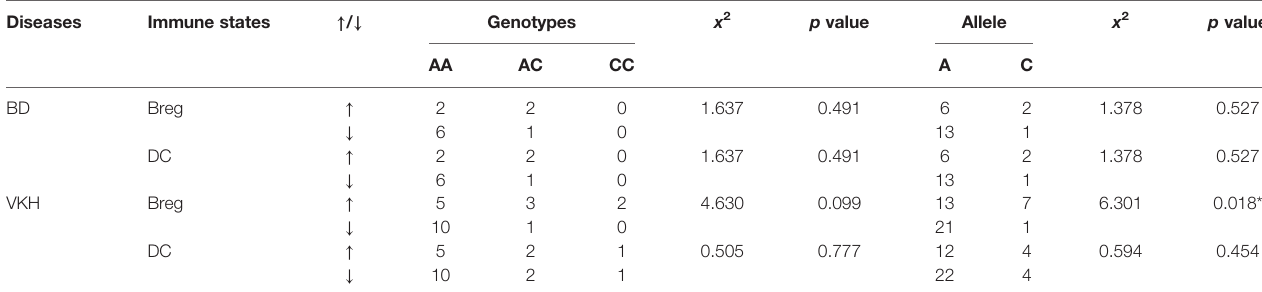
TABLE 5 | Associations of IL-12p35 (rs2243131) with immune states in BD or VKH patients. Diseases Immune